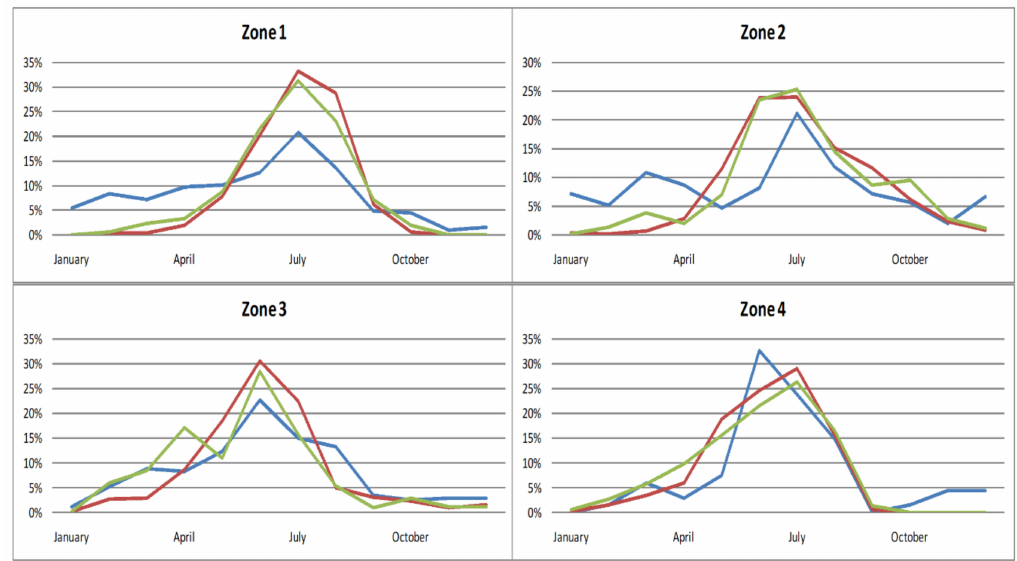
Figure6. Comparisonofaveragepercentagemonthlywildfiresinrecordedperiod(2000–2014)(blueline) and RCP4.5 (red line) and RCP8.5 (green line) scenarios in long-term period